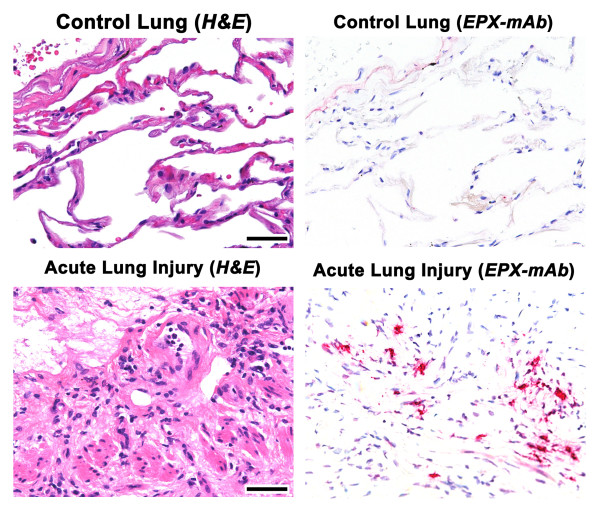
EPX-mAb immunohistochemistry represents a sensitive and novel strategy relative to H&E staining for the detection of infiltrating eosinophils as well as evidence of eosinophil degranulation in the pulmonary parenchyma. Side-by-side comparisons of serial lung sections stained with H&E and sections subjected to  EPX-mAbimmunohistochemistry (red staining cells and extracellular matrix areas) are presented from control subjects and an ALI patient. Scale bar = 50 μm.